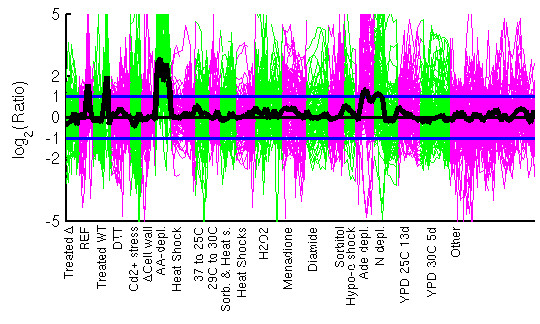
Expression of S. cerevisiae amino acid biosynthesis genes controlled by GCN4 in response to amino acid deprivation from [35] in 174 different stress experiments assembled from various articles. The expression levels are shown as log2 of signal ratios stressed/reference cultures in 174 different stress experiments assembled from various articles [2, 3, 17, 18, 35, 48, 49]. The expression values of individual genes as purpleand greenstriped lines, the median of gene group in black, standard deviation of the whole experiment in blue. Experiment sets are explained in Fig 1.